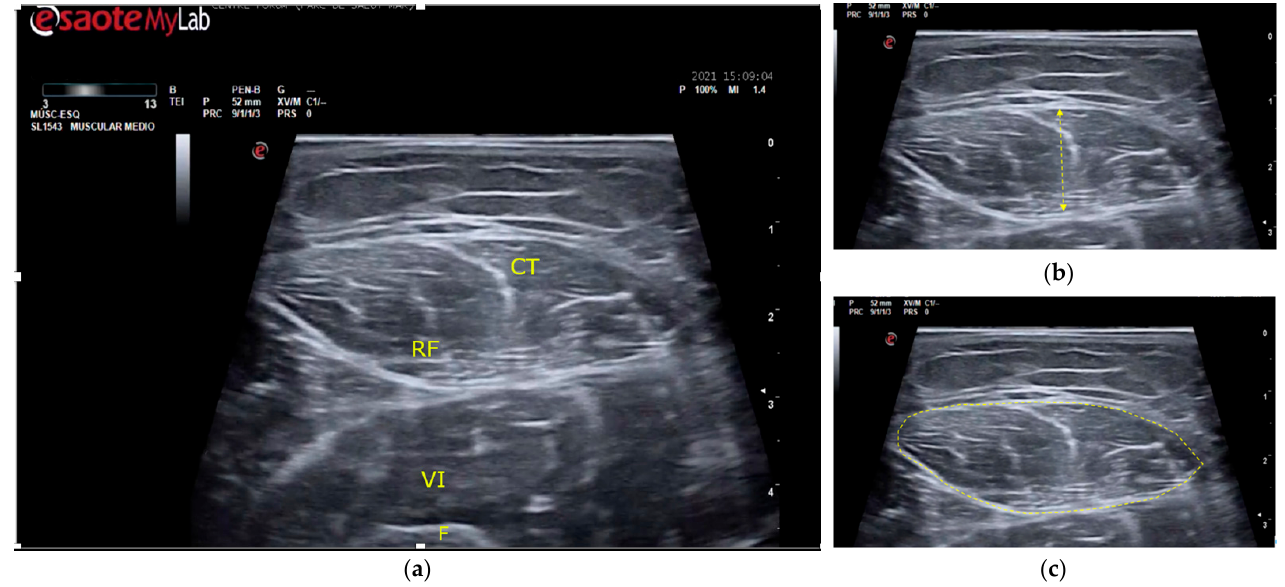
Figure 1. Ultrasound of the rectus femoris muscle for MT and CSA measurement points. ( a ) Guiding structures are shown for proper recognition. RF, rectus femoris muscle; CT, central tendon of RF; VI, vastus intermedius muscle; F, femur. ( b ) MT (muscle thickness) was determined as the distance between the superior and inferior aponeurosis of the RF. ( c ) CSA (cross-sectional area) was measured by delimiting the cross-sectional area of the RF.